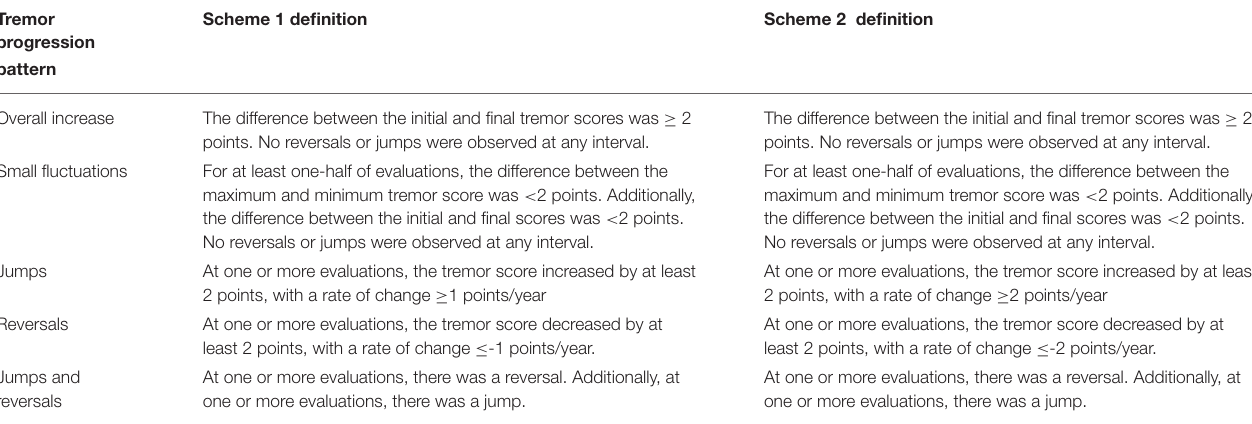
TABLE 2 | Tremor progression patterns.